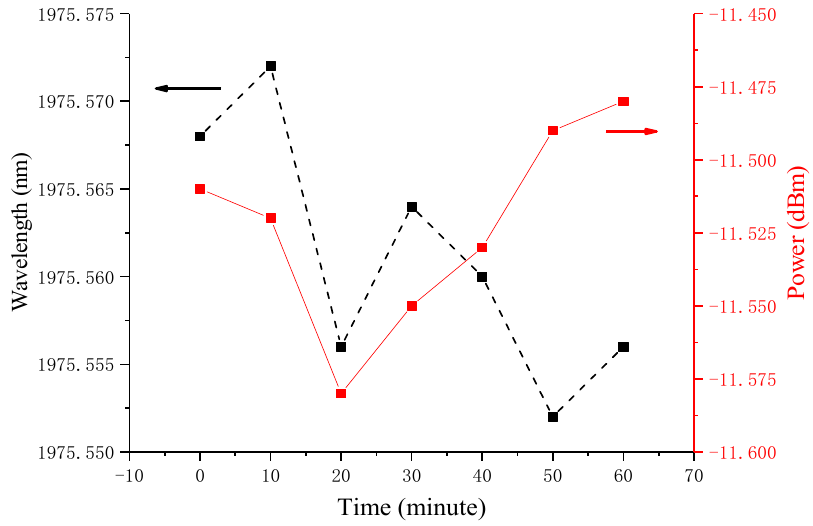
Figure 8. Fluctuation of output power and wavelength of thulium-doped fiber laser within 1 h.